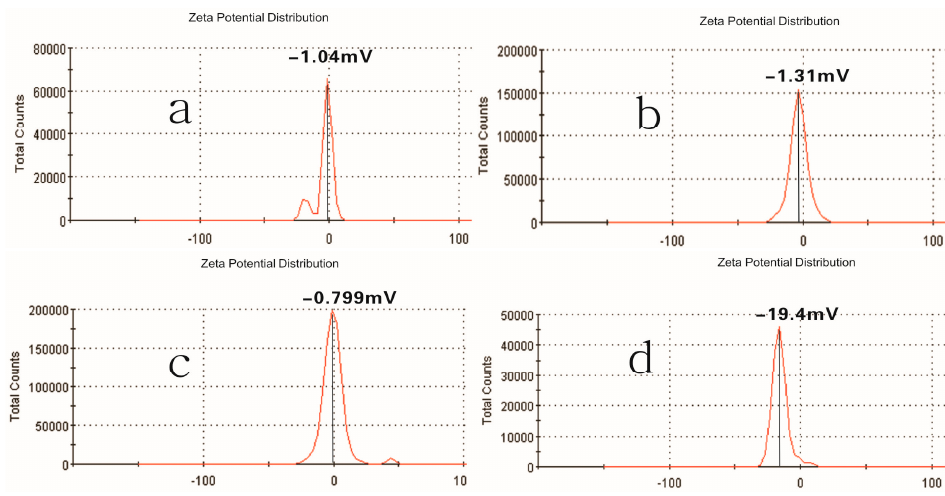
Figure 6. Size distribution of CHP − 6.91 ( a ), CHP − 6.03 ( b ), CHP − 3.11 ( c ) and CHCP ( d ) nanoparticles.